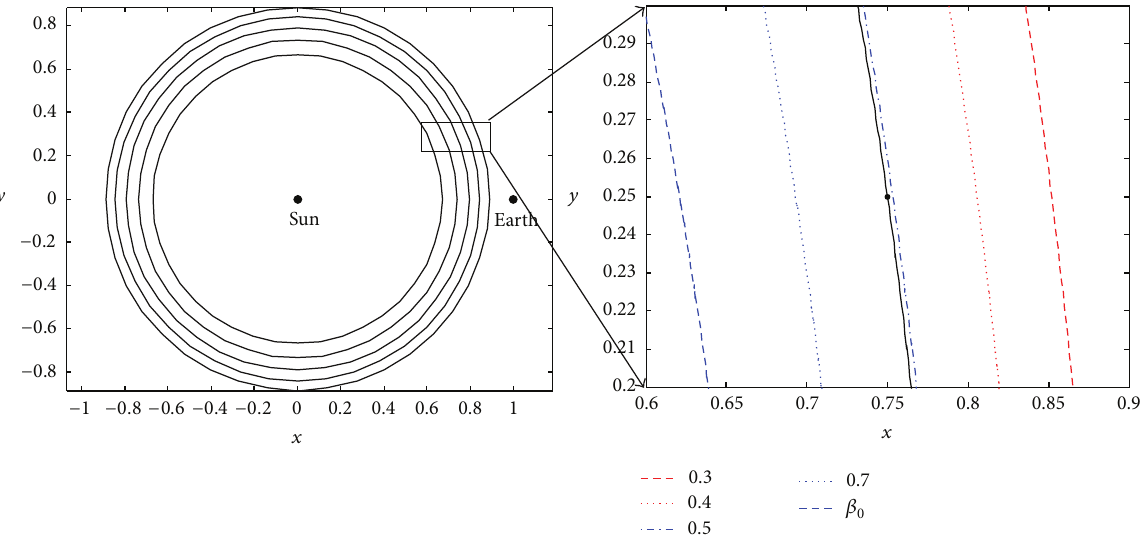
Figure 2: Section of the level surfaces in Sun-Earth/Moon system. 𝛽 0 = 0.5059 .